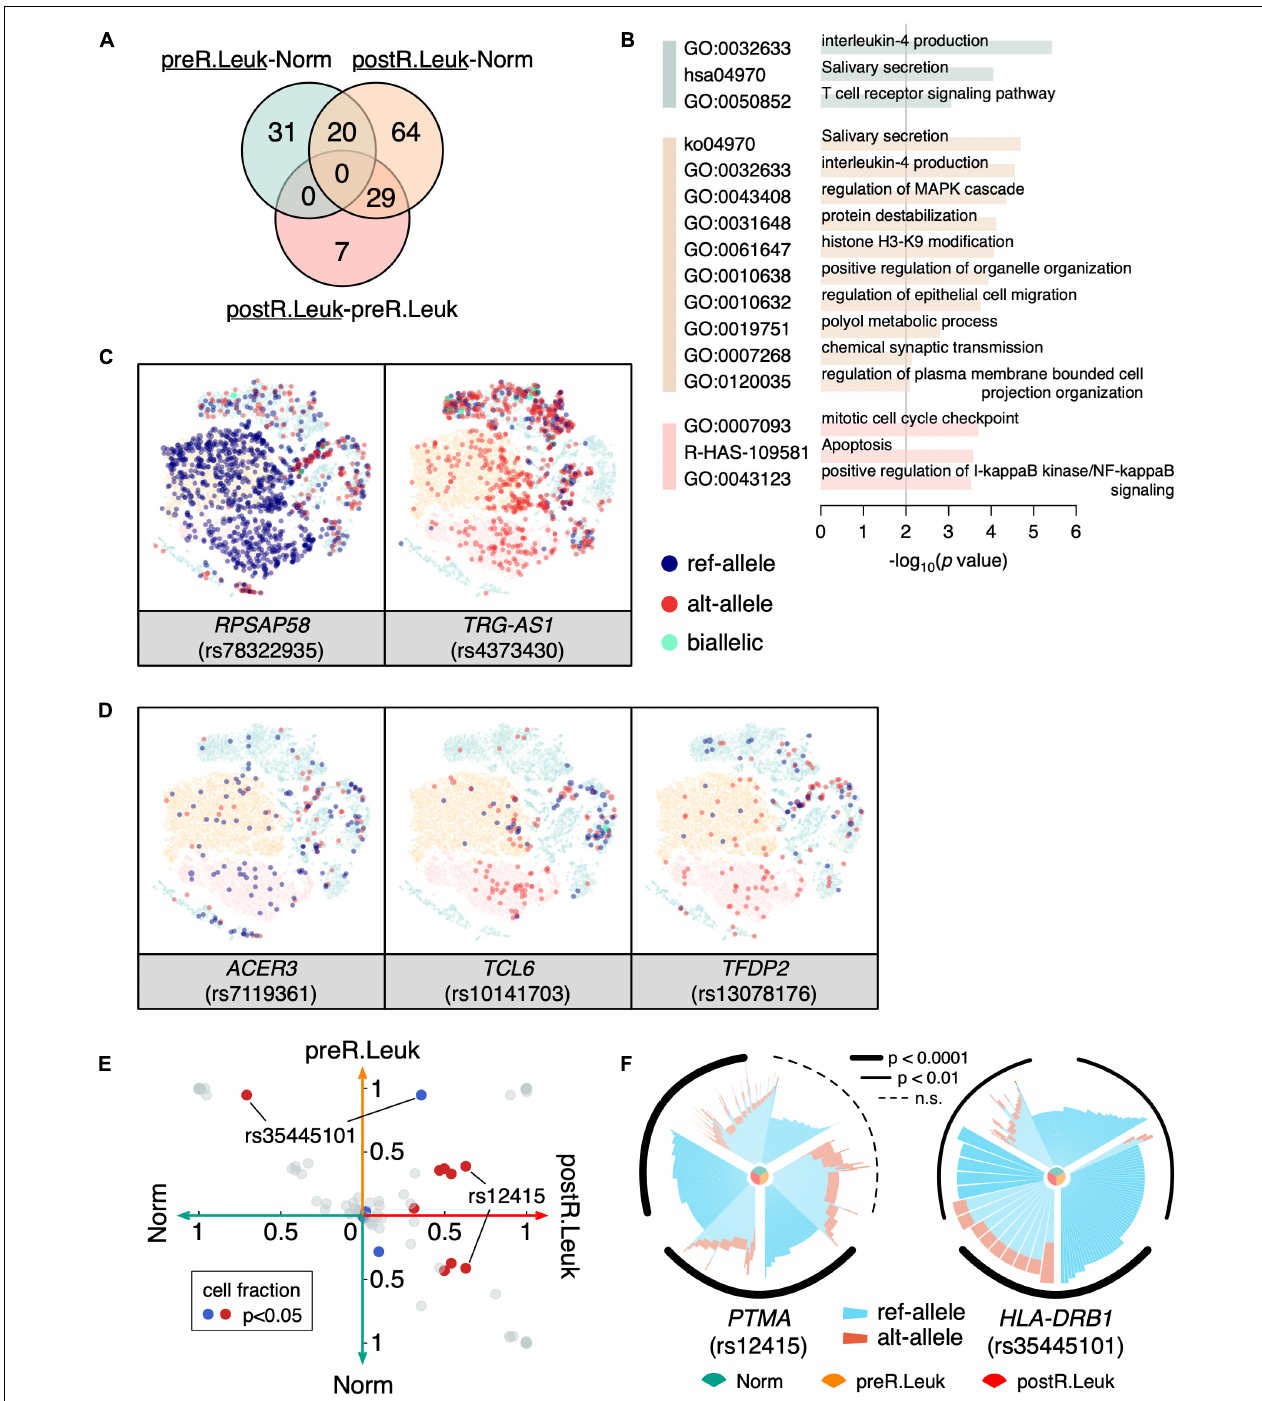
FIGURE 5 | Analyzing the leukemia cell-specific MAEs. (A) Venn diagram shows constitutive MAEs specific to preR.Leuk and postR.Leuk (underlined), after pairwise comparisons. The green circle indicates preR.Leuk-specific MAEs, comparing with Norm, the orange circle indicates postR.Leuk-specific MAEs, comparing with Norm, while the red circle indicates postR.Leuk-specific MAEs, comparing with preR.Leuk. (B) GO enrichment analysis of the leukemia cell-specific MAEs. The colors match with that in (A) . (C) RPSAP58 and TRG-AS1 show Leukemia specific MAEs. (D) ACER3 , TCL6 , and TFDP2 show postR.Leuk-specific MAEs. (E) Pairwise comparison of the detected rMAEs among Norm, preR.Leuk, and postR.Leuk. Each dot represents a rMAE, and the axis indicates the cell fraction of each rMAE, within the corresponding cell sub-population. Significantly biased ( p < 0.05) rMAE in terms of the cell fraction is highlighted in red/blue. (F) Significantly differentiated rMAE among Norm cells, preR.Leuk cells, and postR.Leuk cells. An increased number of cells showed MAE of ref-allele on PTMA (rs12415) in postR.Leuk. HLA-DRB1 (rs35445101) shows increased MAE in preR.Leuk but deceased in postR.Leuk.